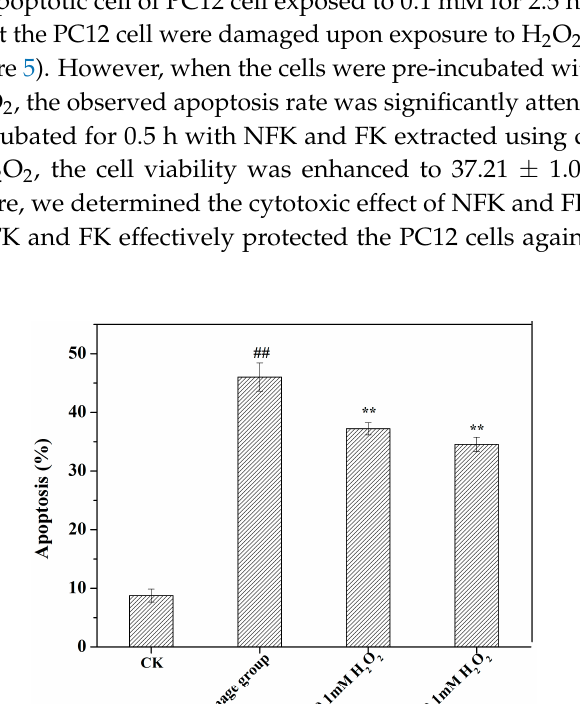
Figure 5. NFK (10 mg/mL) and FK (10 mg/mL) prevent H 2 O 2 -induced PC12 cell apoptosis. The